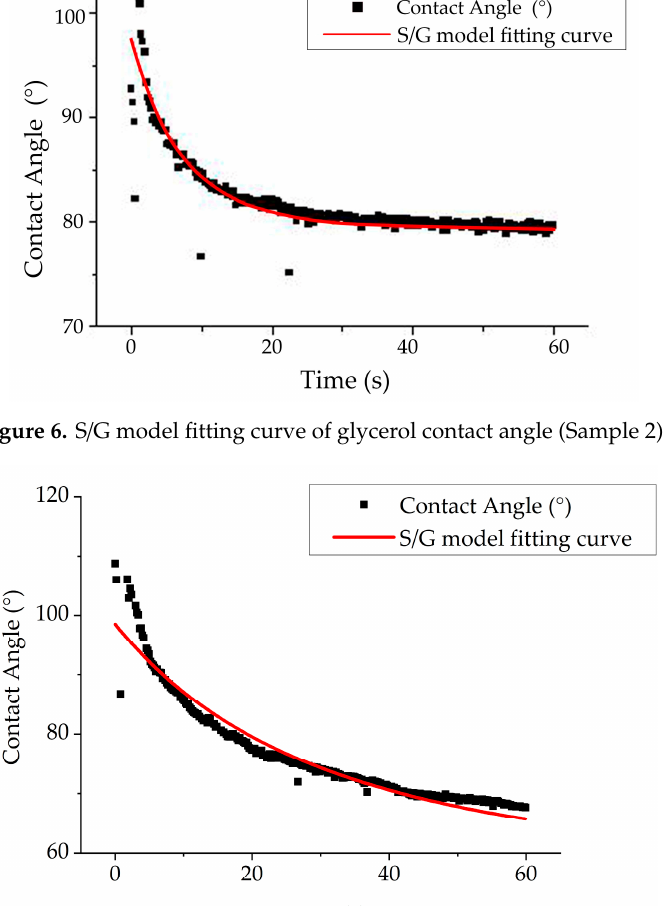
Figure 7. S / G model fitting curve of glycerol contact angle (Sample 3). Coatings 2020 , 8 , x FOR PEER REVIEW Figure 7. S/G model fitting curve of glycerol contact angle (Sample 3). Figure 7. S/G model fitting curve of glycerol contact angle (Sample 3).